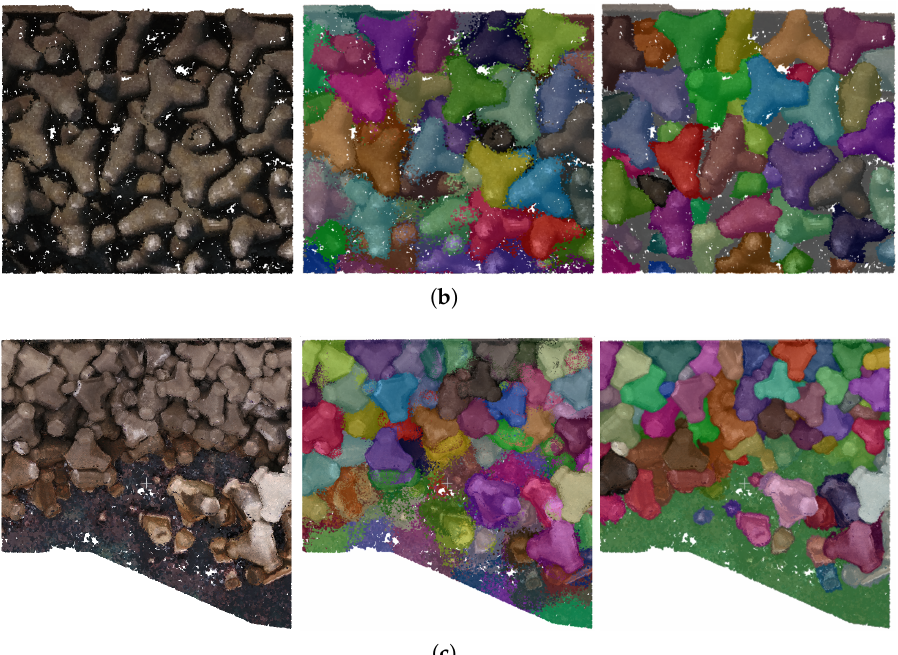
Figure 12. Instance segmentation results on Sawara port ( a ), Todohokke port, ( b ) and Era port ( c ). The left column is the point cloud scene measured by UAV. The middle column is the predicted result of instance segmentation, and the last column is the ground truth. Different colors represent different blocks.